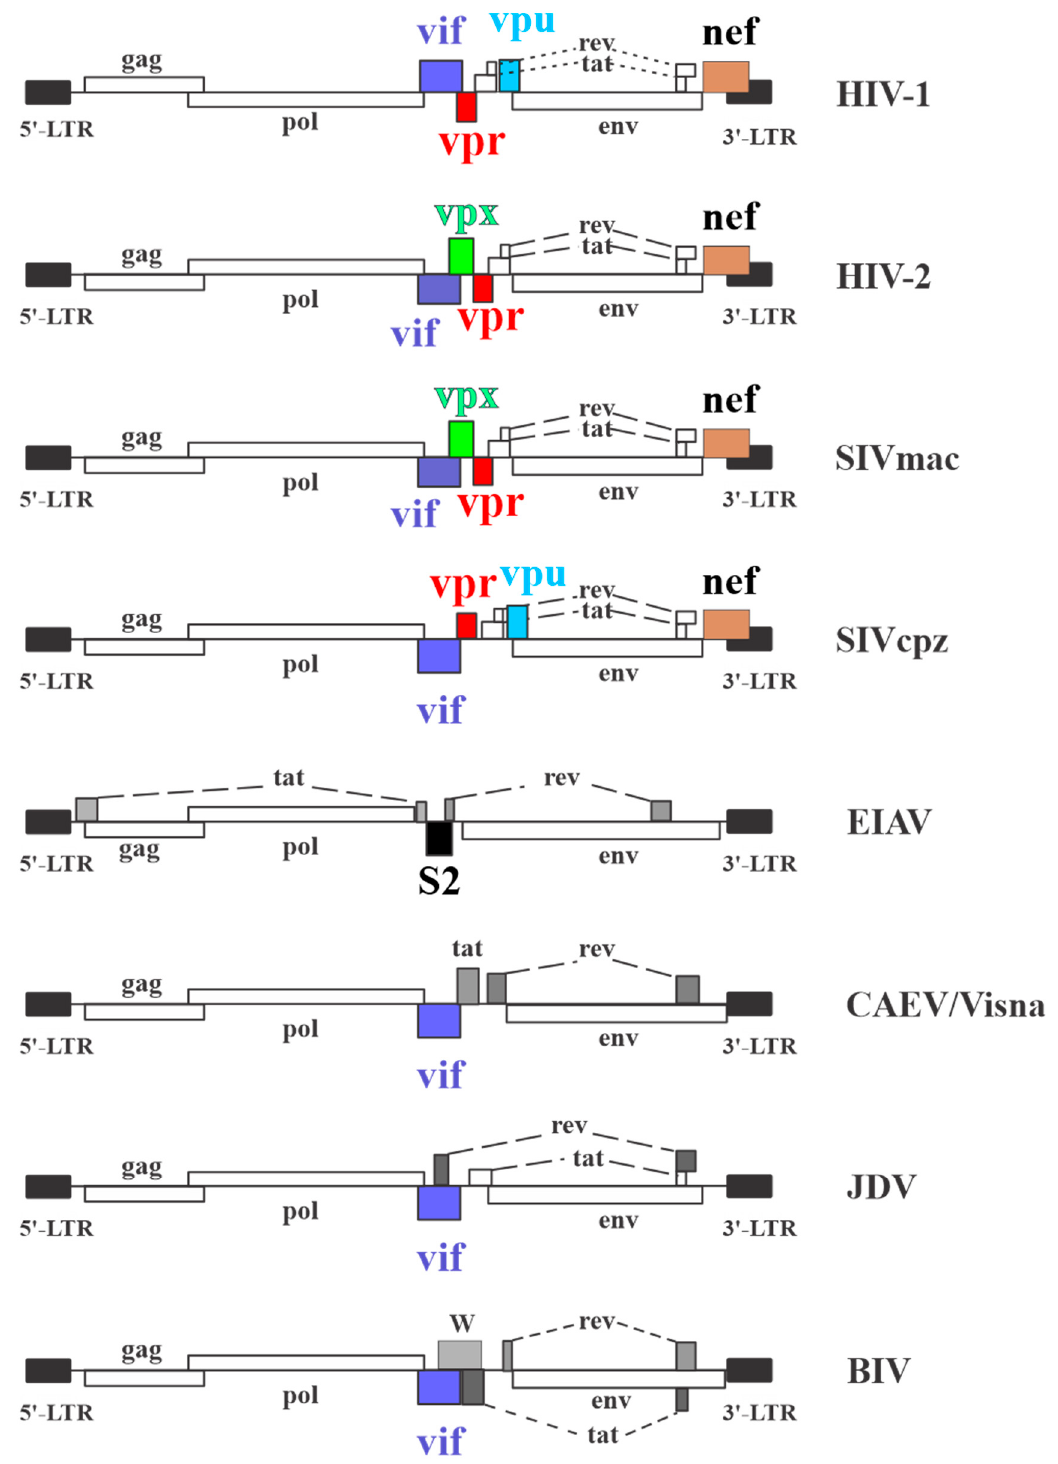
Figure 1. Lentiviral genome organization. Lentiviral genomes share significant similarities with respect to the location of the structural gag , pol , and env genes. However, they di ff er in number and type of accessory proteins. All but EIAV encode a vif gene, and all primate lentiviruses (i.e., human and simian immunodeficiency viruses) encode vpr and nef genes, whereas vpu and vpx genes are limited to HIV-1 and HIV-2 and related viruses, respectively. HIV = Human Immunodeficiency Virus, SIV = Simian Immunodeficiency Virus, EIAV = Equine Infectious Anemia Virus, CAEV = Caprine Arthritis Encephalitis Virus, JDV = Jembrana Disease Virus, BIV = Bovine Immunodeficiency